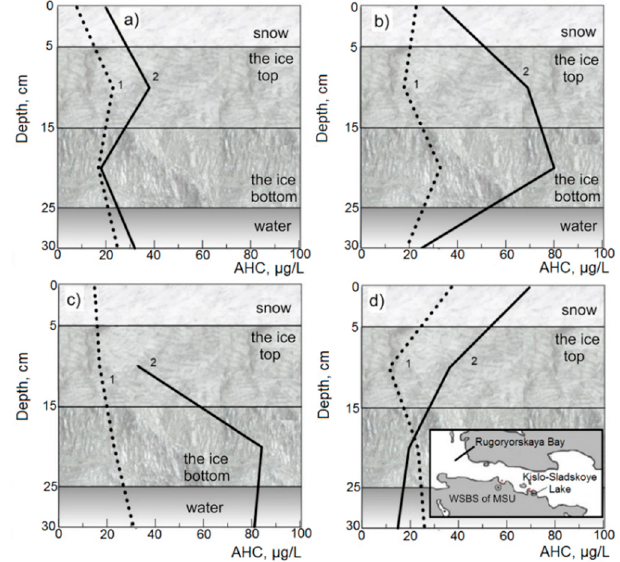
Figure 3. Distribution of aliphatic hydrocarbons in the snow-ice cover of Rugozerskaya Bay: ( a ) 2010, ( b ) 2012, ( c ) 2015, ( d ) 2016; 1—Kislo-Sladkoe Lake, 2—WSBS.